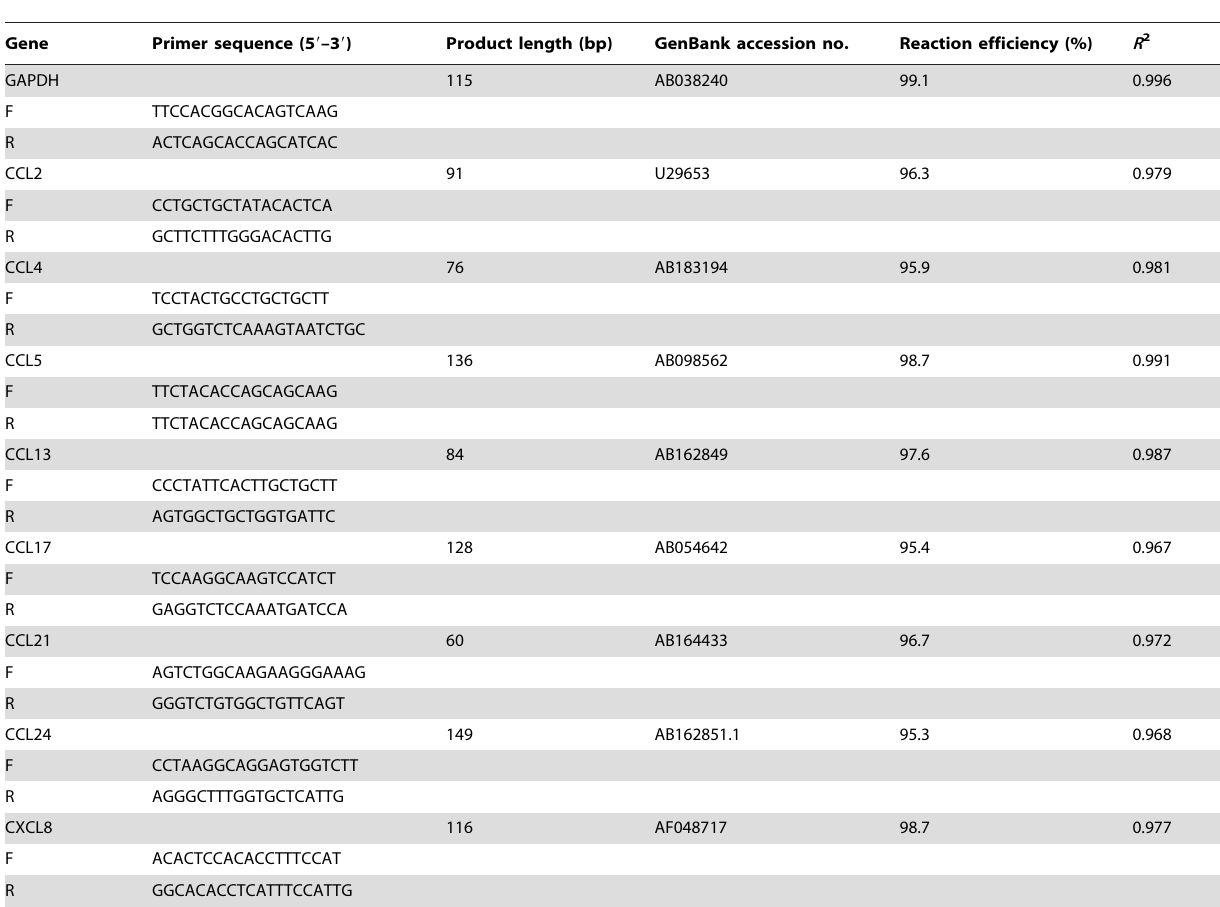
Table 1. Sequences of primers used for quantification of mRNA expression by real-time PCR a .